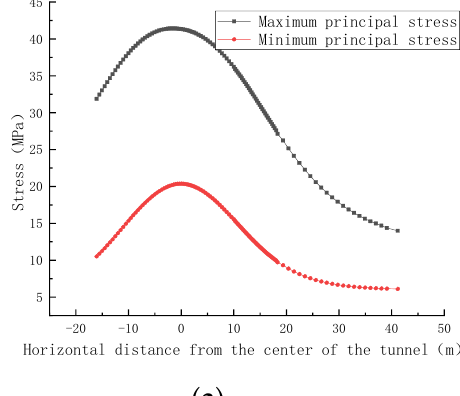
Figure 28. Changes in the principal stresses of the roadway’s surrounding rock when the roadway dug directly below the residual coal pillar. ( a ) Horizontal direction. ( b ) Variation direction.